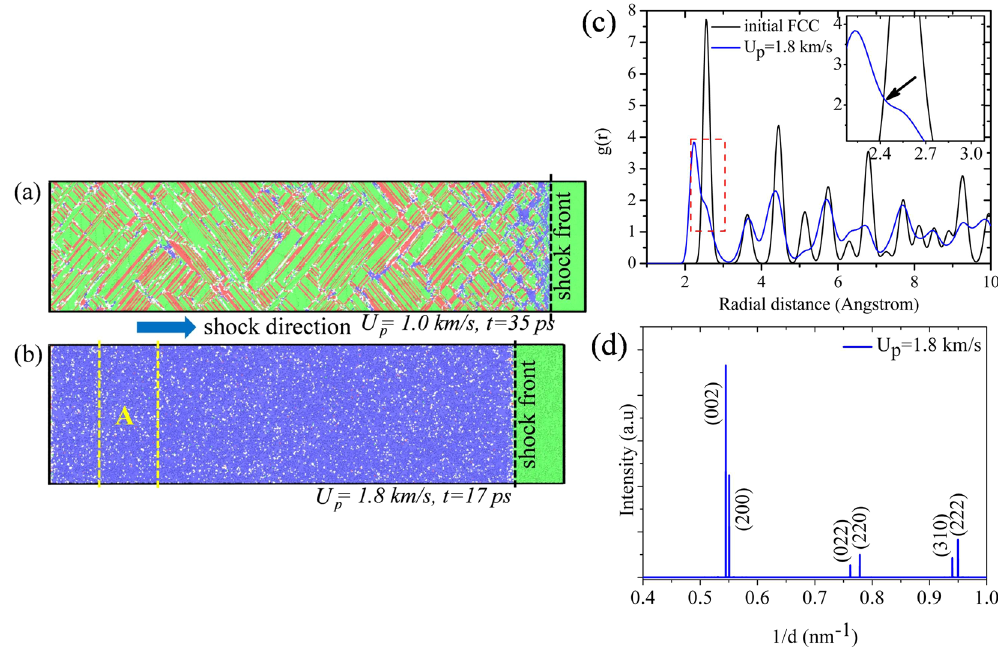
Figure 3. Shock-induced deformation matrix of Cu(100) has been represented for piston velocity of ( a ) 1.0 km/s and ( b ) 1.8 km/s. Local lattice environment has been analyzed through ( c ) radial distribution function (RDF) and ( d ) X-ray diffraction pattern. For identifying local lattice environment adaptive-common neighbor analysis (a-CNA) 32 has been employed as depicted in ( a ) and ( b ), where, color green, blue, red and white represent FCC, BCC, HCP and unidentified phase respectively. Black dashed line indicates the position of shock front at particular time instance as mentioned in the figure. Region ‘A’ (a 150 Å thick slice far behind the shock front) as shown in ( b ) (bounded by yellow colored dashed line) has been considered for characterizing lattice structure through RDF and XRD, as represented in ( c ) and ( d )